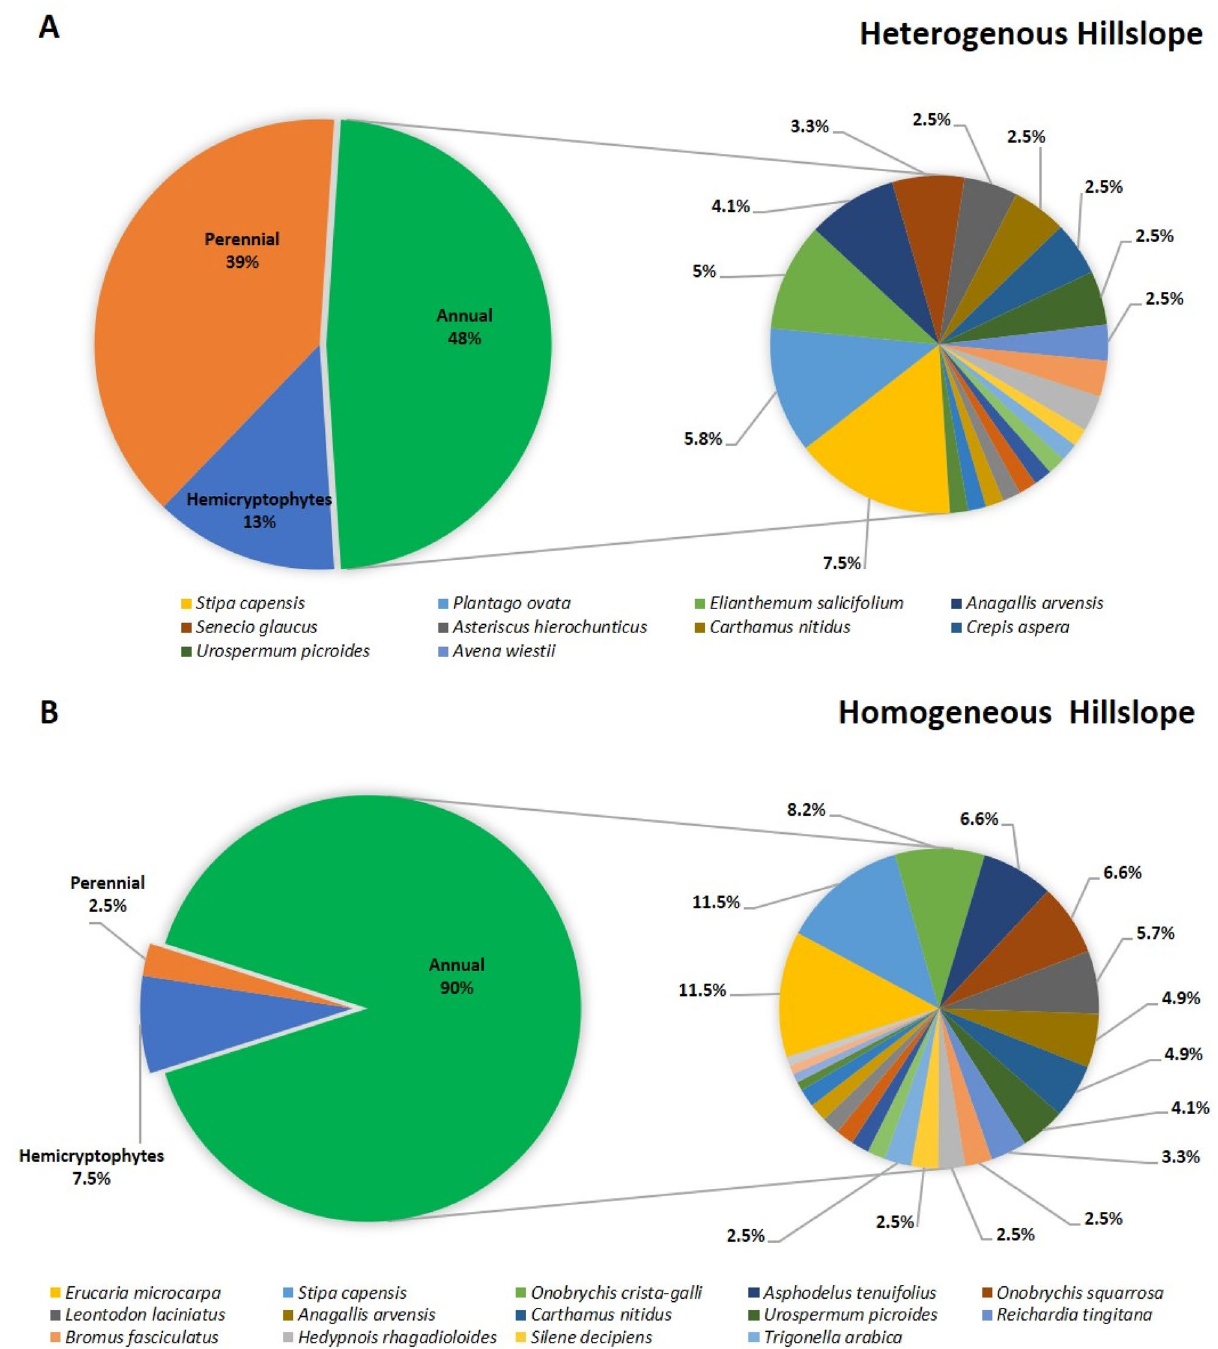
Figure 5. Life form composition in heterogeneous ( A ) and homogeneous ( B ) hillslopes. Differentiation among perennial (red), herbaceous perennial (blue), and annuals (green) is presented in the left circles, and species- level differentiation of annuals is presented in the right circles (only species that represent more than 2% were included in the figure). For the total list of the species SI